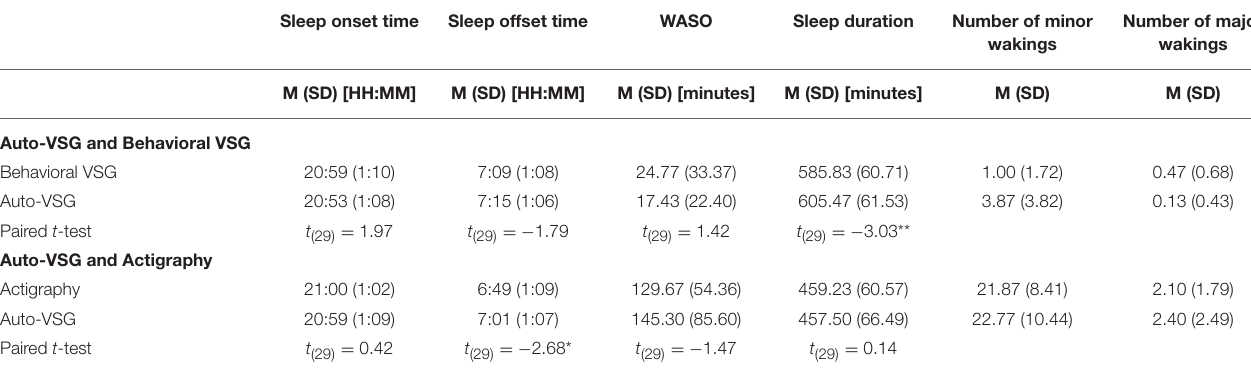
TABLE 4 | Paired-sample t -test for automated videosomnography (auto-VSG), behavioral VSG, and actigraphy. Sleep onset time Sleep offset time WASO Sleep